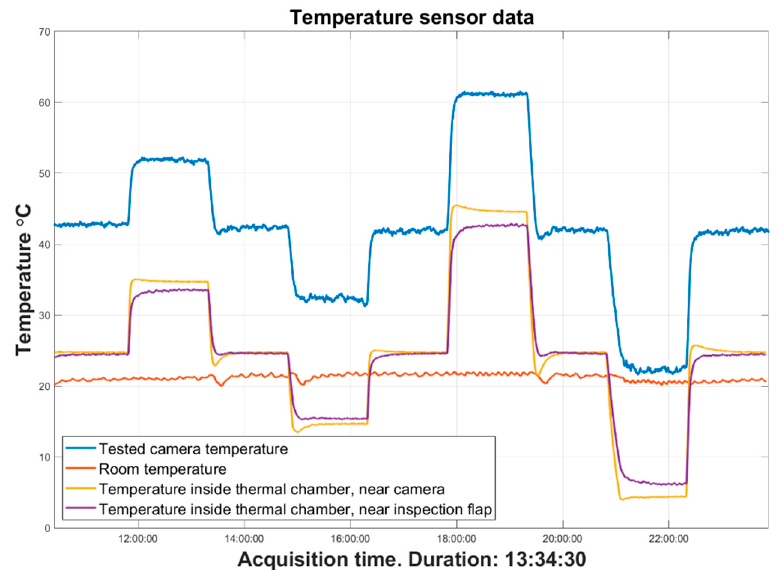
Figure 6. Temperature data recorded during the stability measurement. The blue line refers to the temperature of the observed camera inside the thermal chamber, recorded by a sensor inside the camera; the orange line refers to the room temperature of the lab recorded by the sensor positioned near the image artifact; the yellow line refers to the temperature inside the thermal chamber, recorded by the sensor positioned near the observed camera; the purple line refers to the temperature inside the thermal chamber recorded by the sensor positioned near the inspection flap.